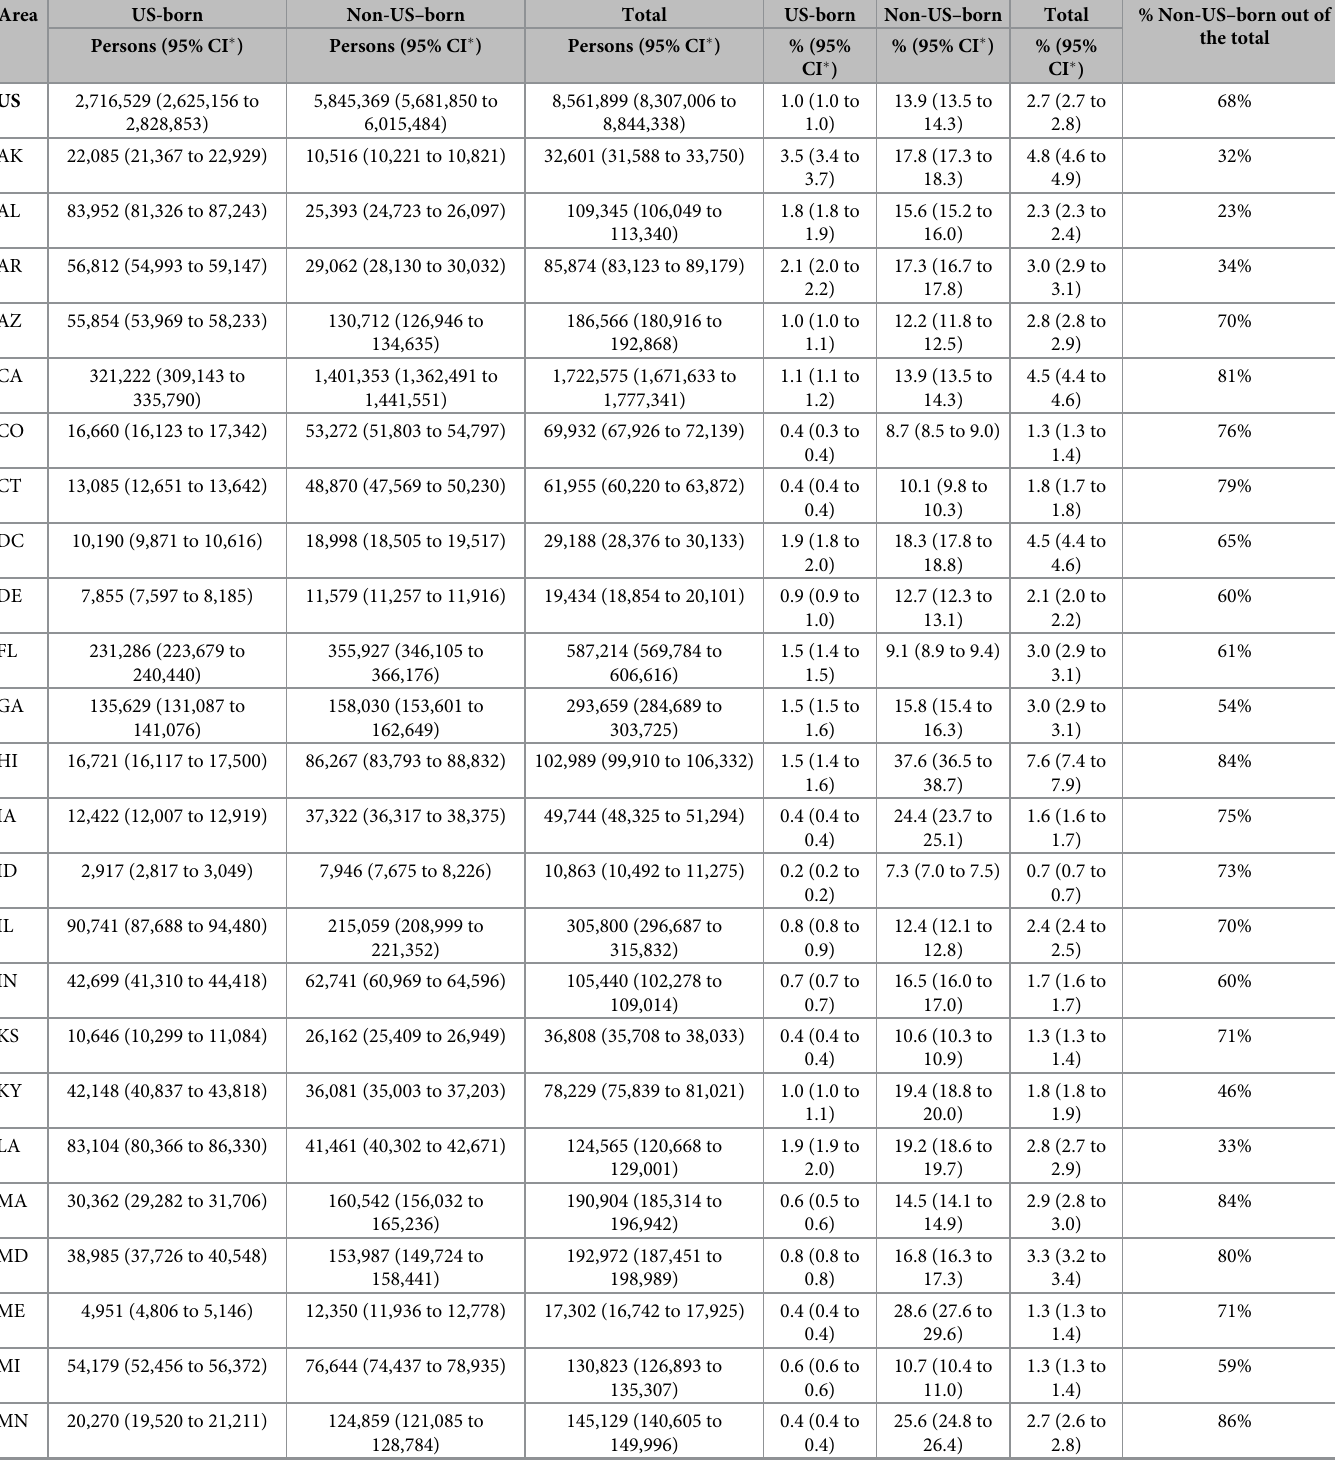
Table 3. Estimated number and proportion of persons living with latent tuberculosis infection in 2015, stratified by nativity and in total population, in 50 U.S. states and District of Columbia.